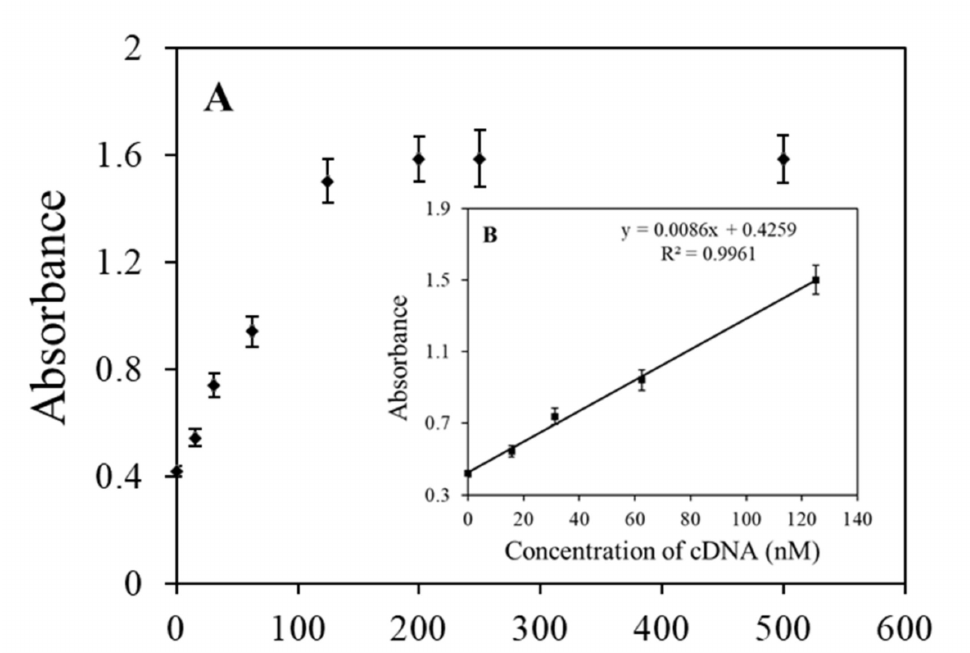
Figure 4. Colorimetric signal changes in the G-4/hemin mixture as a function of the concentration of perfectly matched cDNA. ( A ) Calibration curve for determination of the cDNA; ( B ) Linear correlation at a concentration range of 0–125